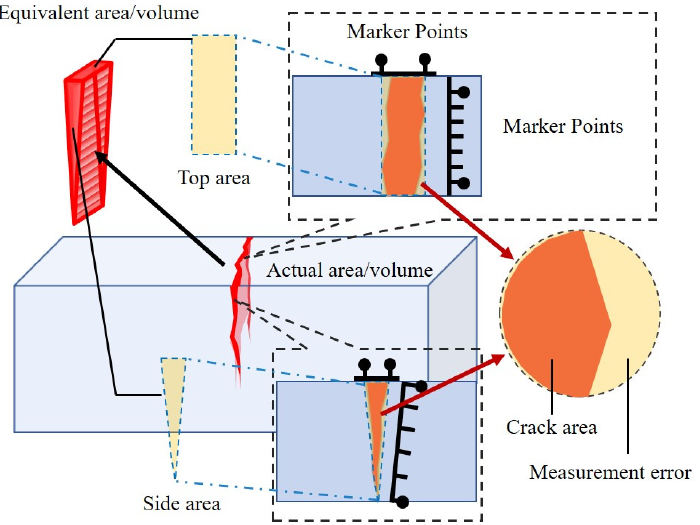
Figure 9. Schematic representation of specimen repair markings and